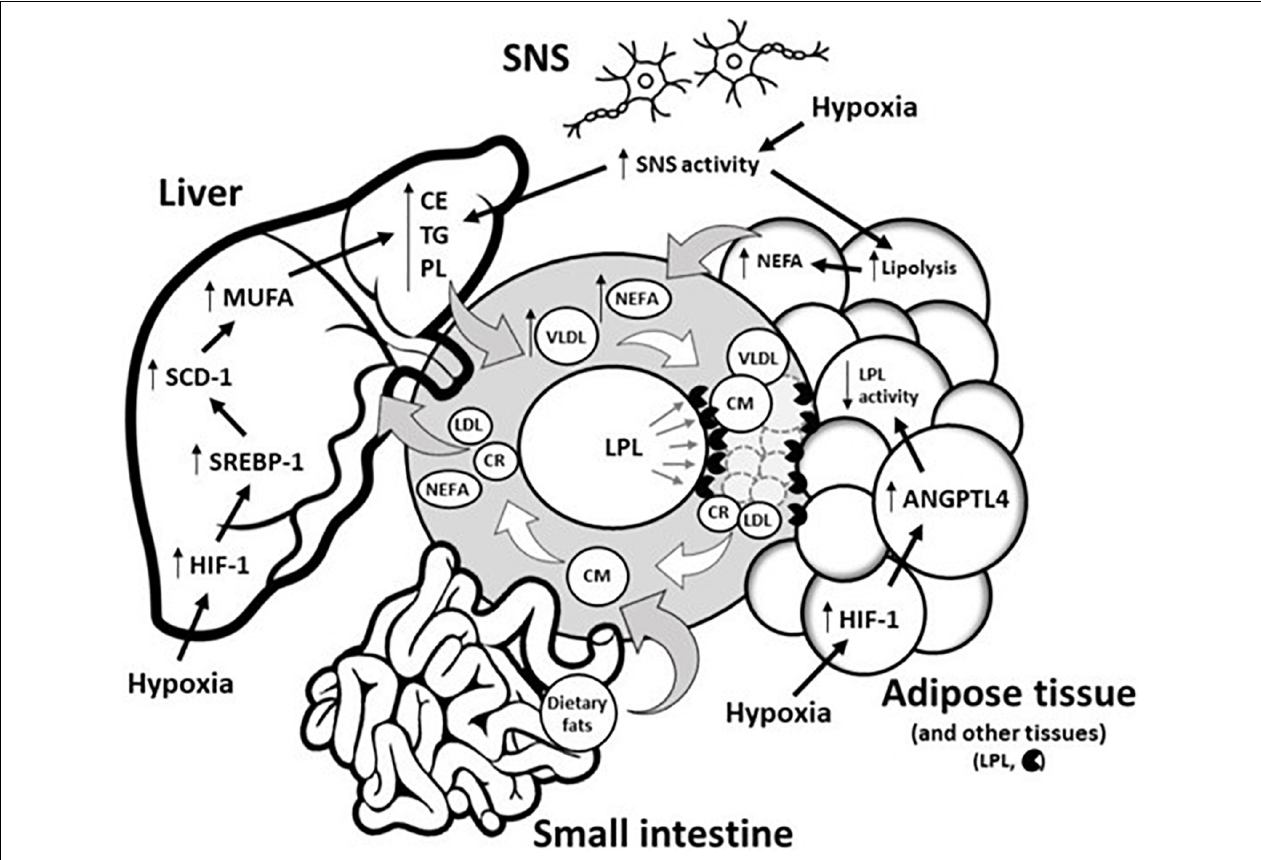
FIGURE 1 | Potential underlying physiological mechanisms by which hypoxia modulates blood triglyceride levels. Circulating TG levels reflect the production of TRL by both the liver (as VLDL) and the intestine (as CM) as well as the disposal of TRL and their remnants (LDL and CR) in the liver/periphery. Hypoxia does not disturb CM metabolism in the small intestine. Conversely, hypoxia disturbs hepatic and adipose tissue functions by (1) delaying hepatic removal of TRL remnants from circulation, and/or (2) delaying intravascular lipolysis of TRL via the HIF-1 upregulation of ANGTPL4, a potent inhibitor of adipose tissue LPL activity. In the liver, hypoxia also increases lipid biosynthesis via HIF-1-dependent upregulation of the transcriptional factor SREBP-1, which increases expression of SCD-1, the rate-limiting enzyme for the synthesis of MUFA, a major substrate for the synthesis of CE, TG, and PL. These latter substrates are key determinants involved in VLDL production. Through sympathetic activation, hypoxia can also increase VLDL production by (1) directly increasing VLDL assembly in the liver, and/or (2) by stimulating intracellular lipolysis of adipose tissue, which results in the increased release of NEFA, the main precursor to VLDL production. ANGPTL4, Angiopoietin-like 4; CM, Chylomicron; CR, Chylomicron remnant; CE, Cholesterol ester; HIF-1, Hypoxia-inducible factor 1; LDL, Low-density lipoprotein; LPL, Lipoprotein lipase; MUFA, Monounsaturated fatty acid; NEFA, Non-esterified fatty acid; PL, Phospholipid; SCD-1, Stearoyl-CoA desaturase-1; SREBP-1, Sterol regulatory element-binding protein 1; SNS, Sympathetic nervous system; TG, Triglyceride; VLDL, Very-low-density